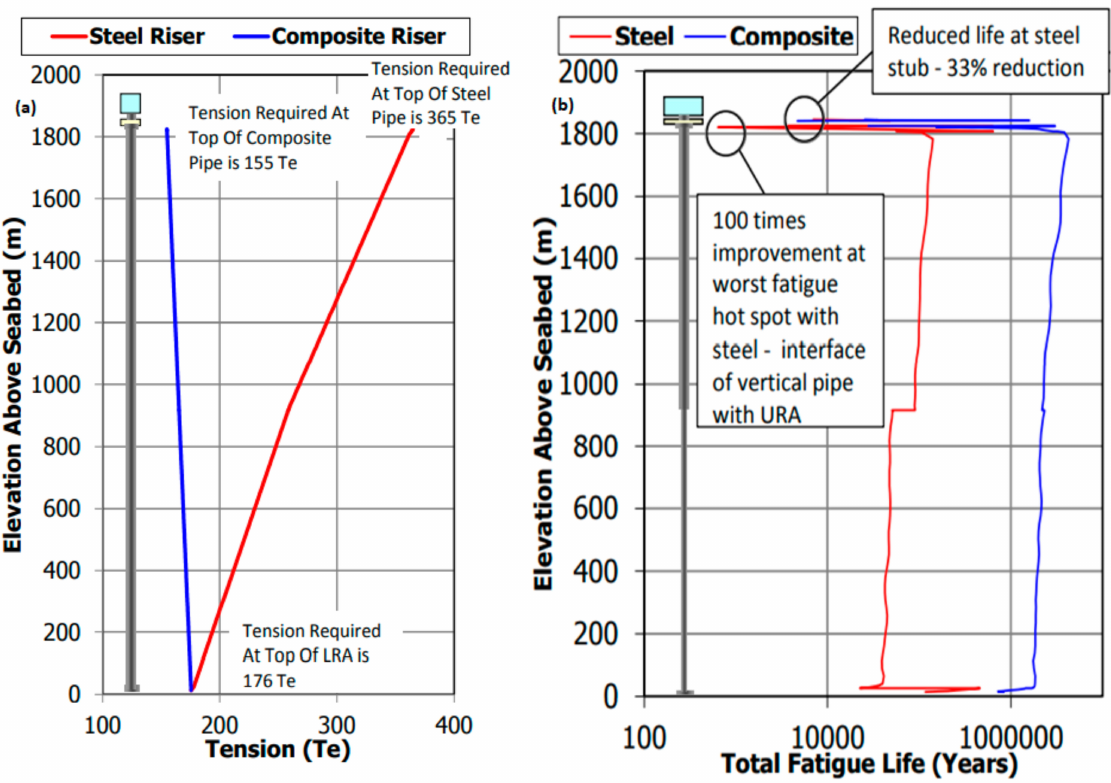
Figure 22. Comparative study on composite riser and steel riser, showing ( a ) tension and ( b ) fatigue life (Courtesy of 2H Offshore; Source: